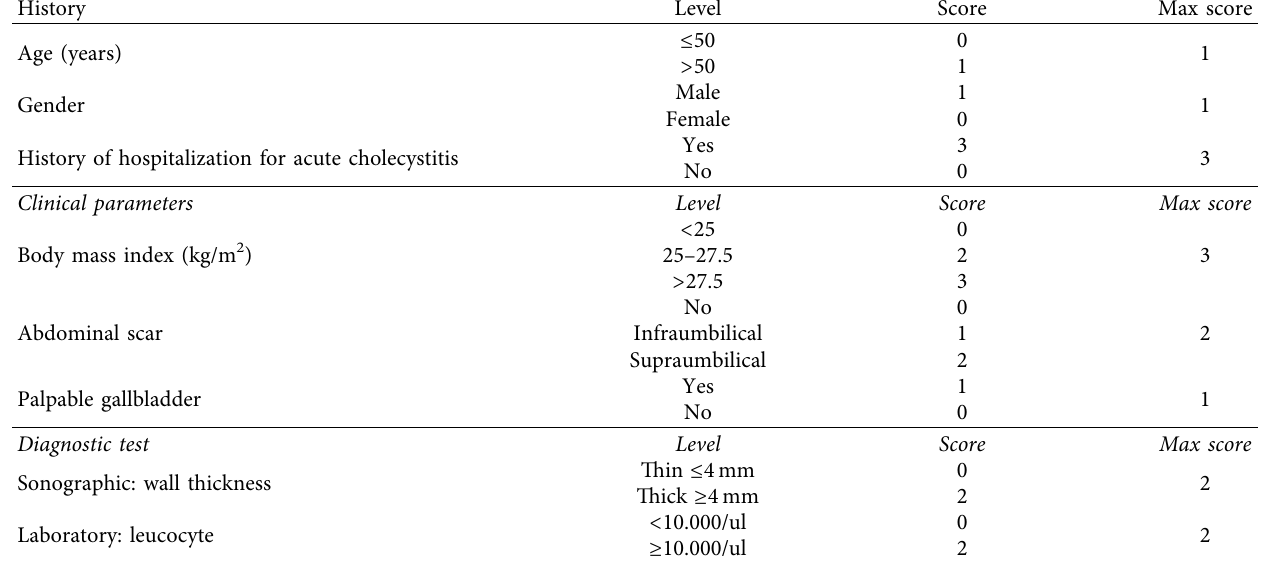
Table 1: Preoperative scoring parameters used for grading the